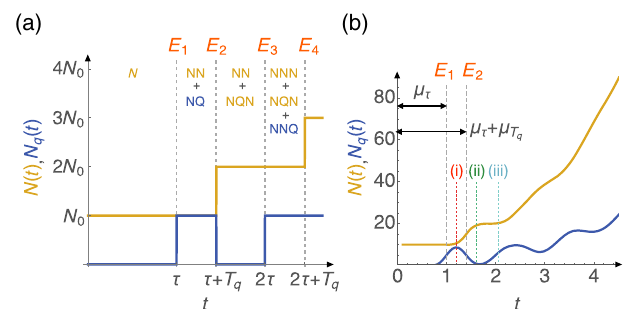
FIG. 4. The physics of transient oscillations. In (a), we sketch a simple example that illustrates how transient oscillations in population numbers arise. See the accompanying text for notation and definition of variables. Initially, N 0 normal cells are present, and population numbers increase as these cells divide and differentiate. The possible lineages of cells present in each demarcated interval are shown as the appropriate sequence of normal ( N ) and quiescent ( Q ) stages in their ancestry, starting at t ¼ 0 , and including their current state. At t ¼ τ , all cells of ð t Þ , while N ð t Þ lineage N divide, causing an increase by N 0 in N q remains equal to N 0 . At t ¼ τ þ T , the quiescent cells differ- q entiate synchronously, creating the lineage NQN. This results in a ð t Þ and increase in N ð t Þ , each by N simultaneous decrease in N 0 . q The next change in numbers occurs with the division of all cells of NN lineage at t ¼ 2 τ . In this manner, the persistence of distinct lineage identities causes distinct fractions of the population to undergo division or differentiation synchronously, resulting in the observed population oscillations. In (b), we show the correspond- ing transient oscillations in population numbers for a realistic model where division and differentiation occur probabilistically. See the Fig. 6 legend for the parameter values used; for these ¼ 0 . 4 . From the parameter values, we find that μ τ ¼ 1 and μ T q times at which the first oscillation in quiescent cell populations begins and ends, we can deduce the mean cell division ( μ τ ) and differentiation ( μ ) times [compare with panel (a)]. The age T q distributions at the transient times (i) – (iii), corresponding to stages 2 – 4 in (a), are shown in Fig. 5. All curves were calculated from our exact analytical time-dependent solutions (see the Appendix for